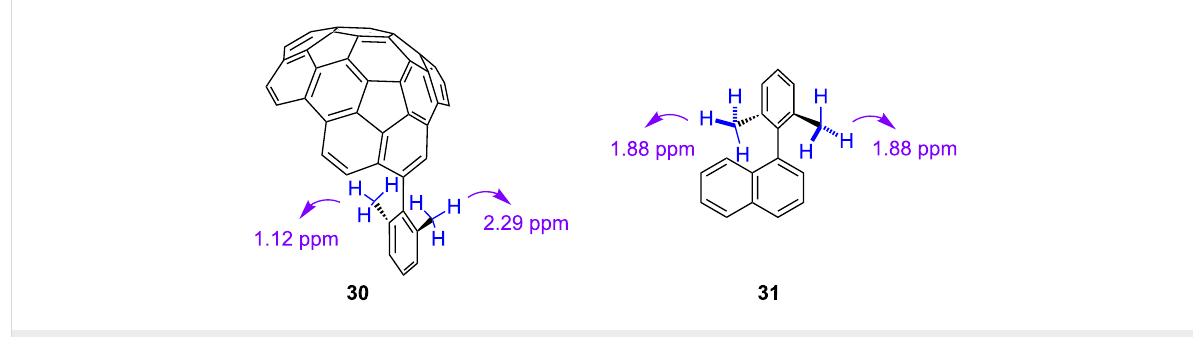
Figure 10: Chemical shifts of ortho -methyl groups in 30 and 31 .